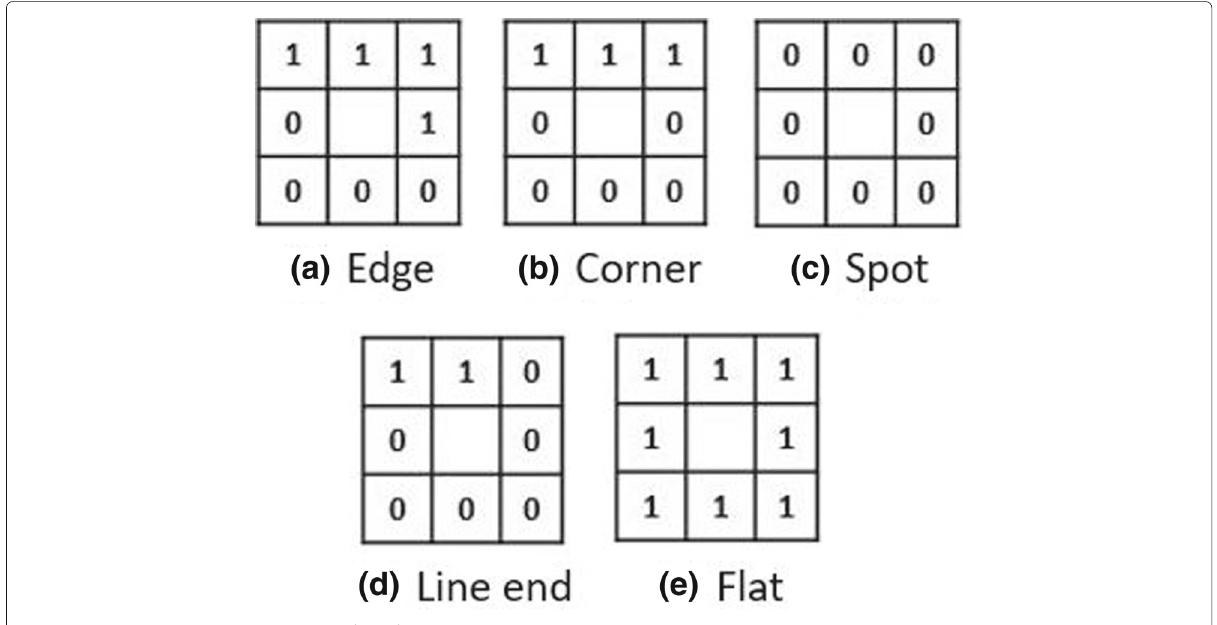
Fig. 9 a – e Microstructure pattern LBP code with P = 8, R = 1 bits are converted to decimal and assigned to the center pixel. This process is repeated for all pixels in an image to obtain LDP representation of the image. Figure 12 shows the process of encoding an image using LDP operator. Given an image region as shown in Fig. 12a, LDP response in the east direction is obtained by convolving the 3 × 3 image region shown in Fig. 10 with the East M 0 mask shown in Fig. 11 top-left corner as: